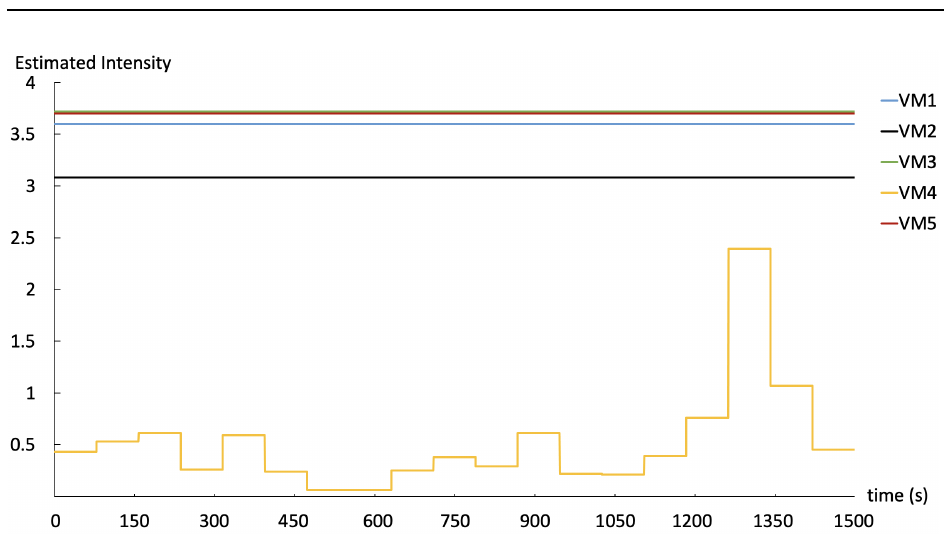
Figure 3. Estimated intensities of the VMs. From Figure 3, we can find that the task arrival rates for VM1, VM2, VM3, and